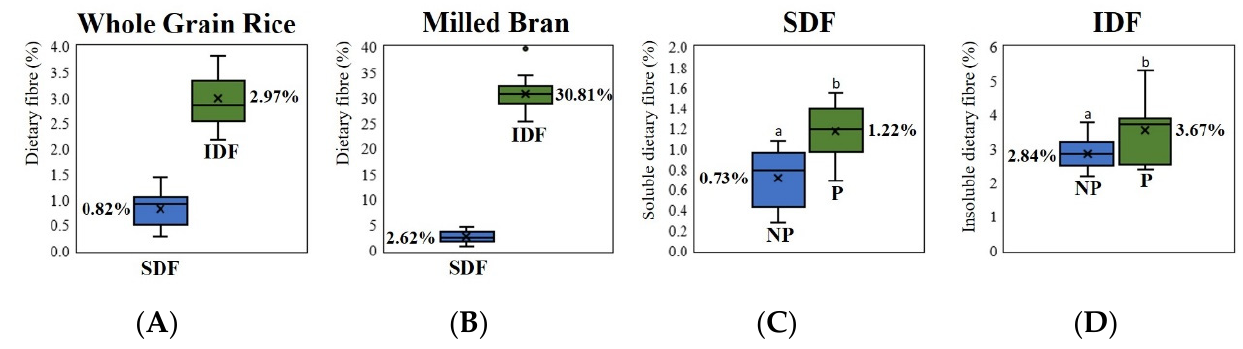
Figure 3. Overview of variation in SDF and IDF distribution ( A ) in whole grain rice samples varying from high amylose content (AC) to low AC, expressed as the percentage of total grain weight and ( B ) in milled bran samples expressed as the percentage of rice bran powder; the difference in ( C ) SDF or ( D ) IDF of whole grain non-pigmented (NP) and pigmented (P) rice, expressed as the percentage of total grain weight. Values with different letters are significantly different with p <